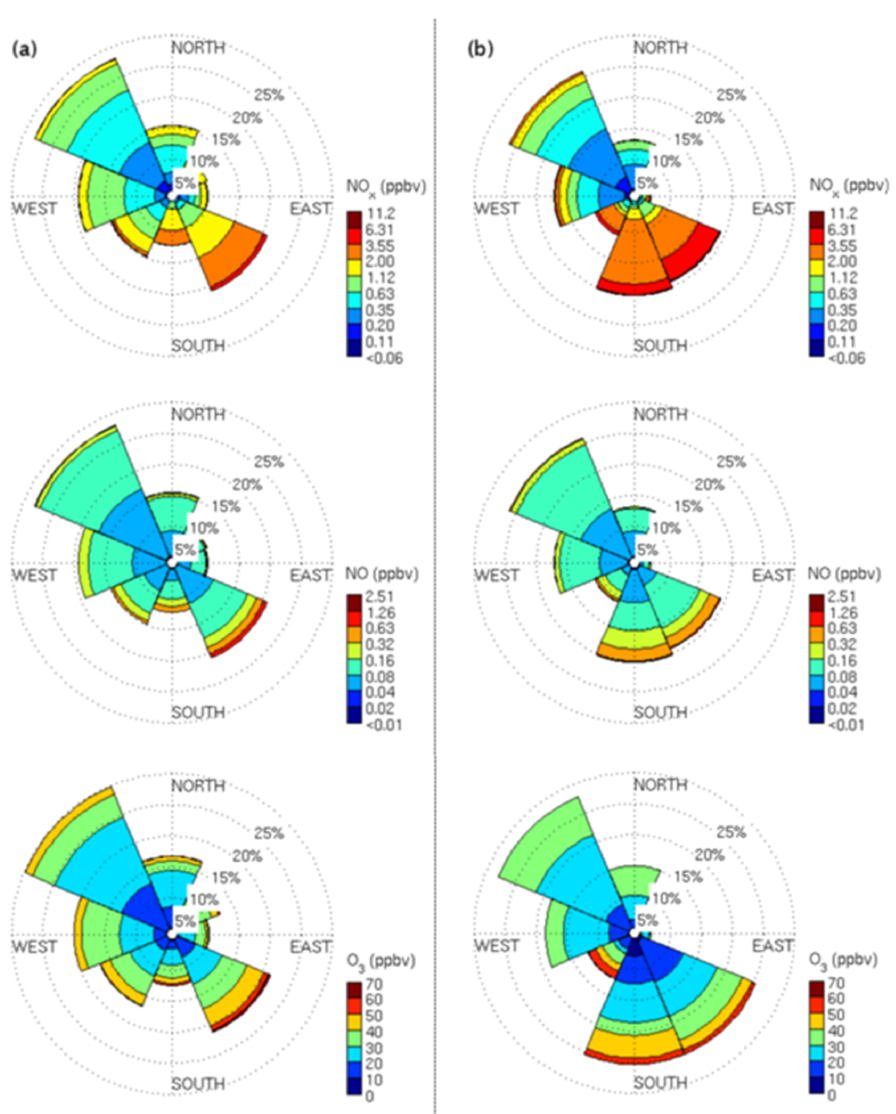
Fig. 5. Wind-pollution rose for NO x , MO , NO, and O 3 determined for (a) August and for (b) November using data from the 46m level wind sensor and 34 m level gas inlet (see Fig. 1).